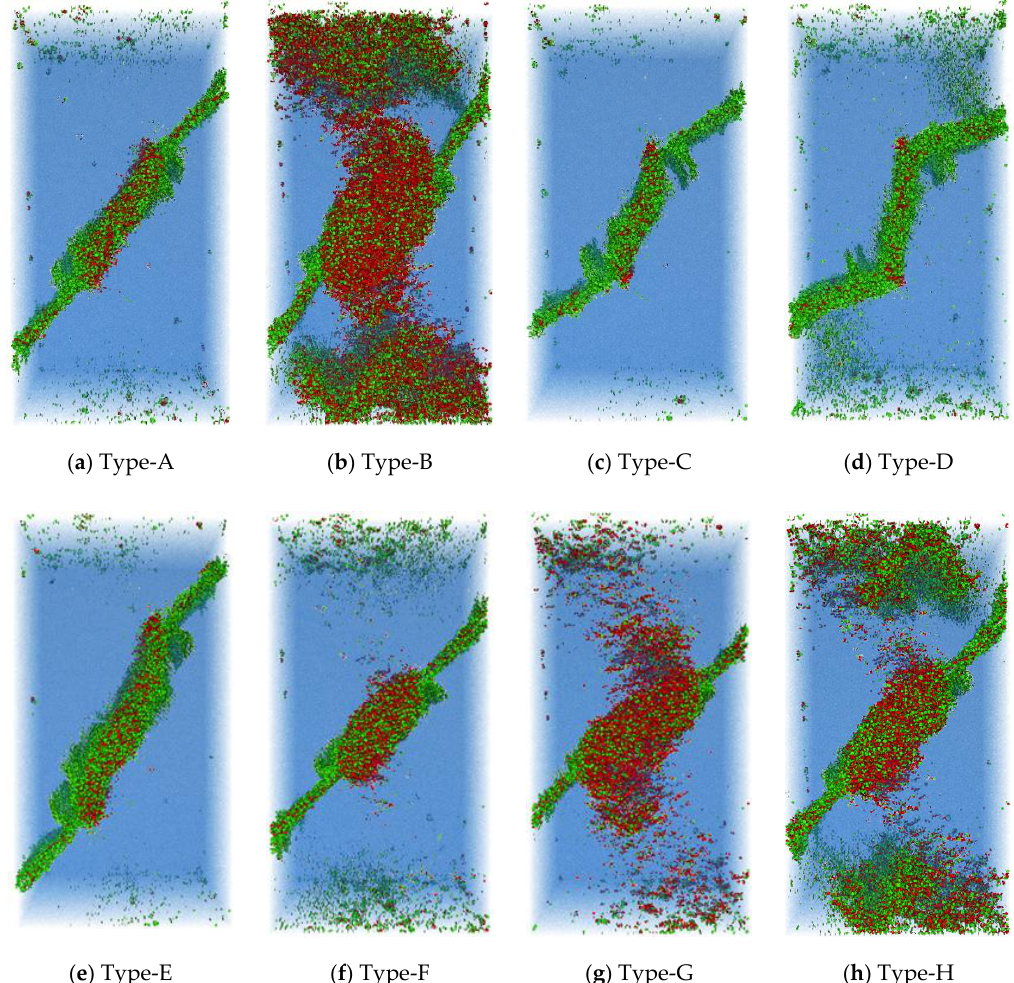
Figure 8. 3-D final failure patterns of the pre-fissured marble specimens in the conventional triaxial compressive simulations.